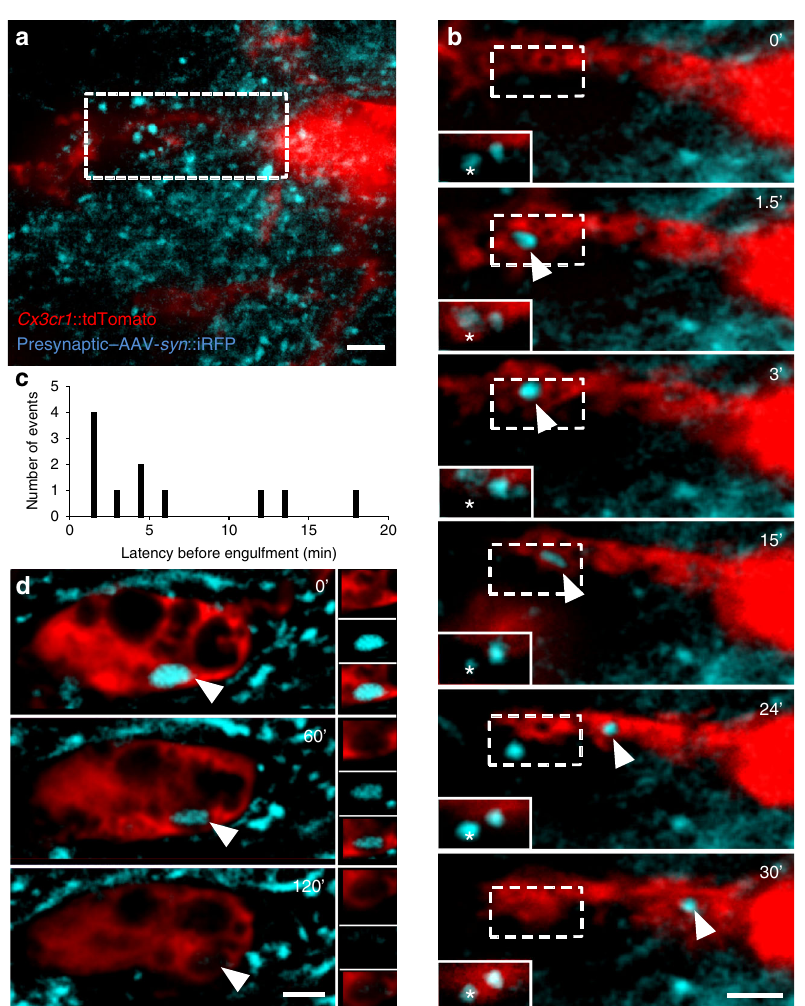
Fig. 4 Rapid trogocytosis of presynaptic material by microglia. a Low-magni fi cation image of a stack projection of 35 consecutive optical sections ( Δ z = 0.48 µ m) showing microglia (red, Cx3cr1 ::CreER; RC ::LSL-tdTomato) surrounded by iRFP + presynaptic boutons from Schaffer collaterals (blue, AAV- Syn :: iRFP) in the CA1 region of organotypic hippocampal cultures. b Time-lapse imaging revealed engulfment of a presynaptic bouton (single optical planes series from a , dotted box). The corresponding optical plane containing the presynaptic bouton (star) is shown in the plain white insert. Although most of the bouton has been internalized by the microglia and traf fi cked toward the soma (arrowhead), presynaptic material remains at the original site (star), indicating partial elimination. c Distribution of the latency to engulfment (n = 11 events from 8 cells originating from 3 organotypic slice cultures). d Representative image of an iRFP + inclusion in a microglia soma (arrowhead) showing slow degradation. Scale bars: 2 µ